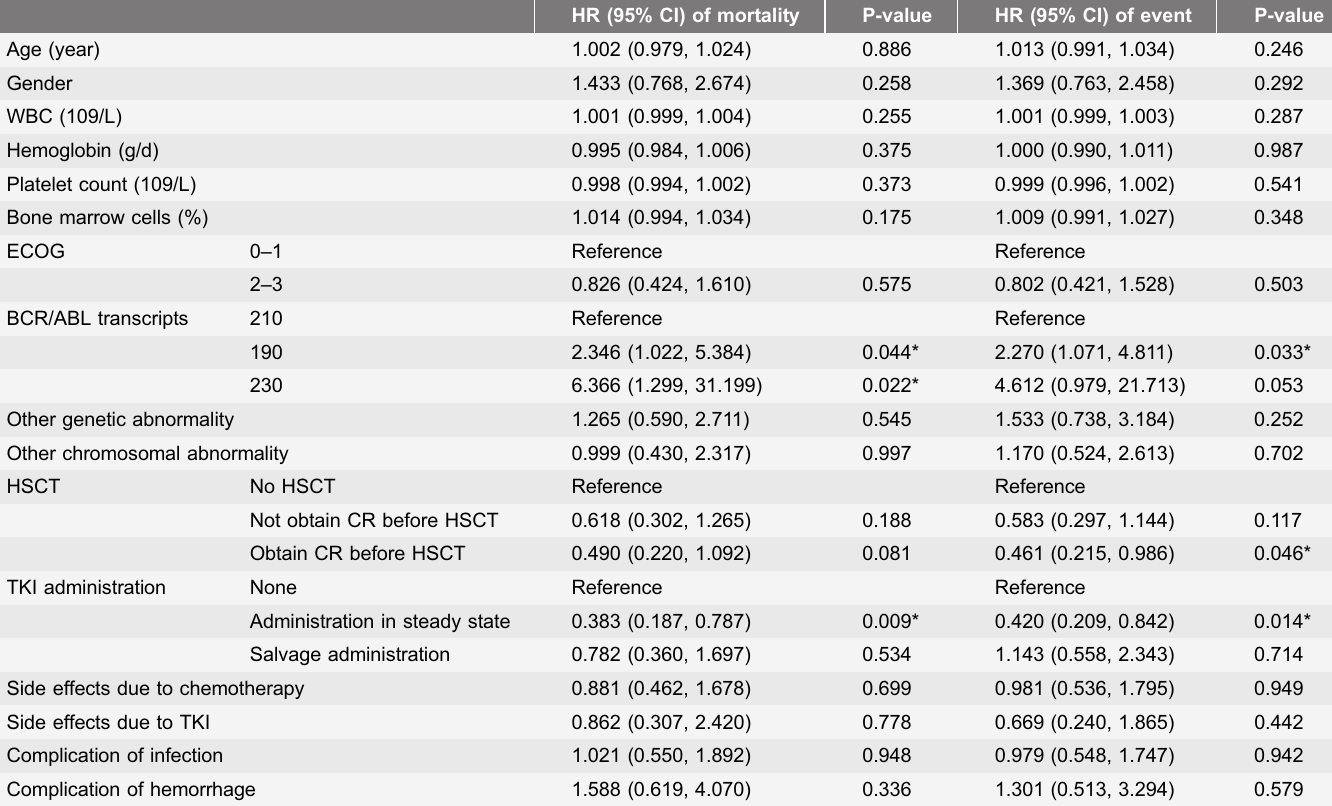
Table 3. Univariable Analysis: Contributing Factors for Mortality and Event Status.